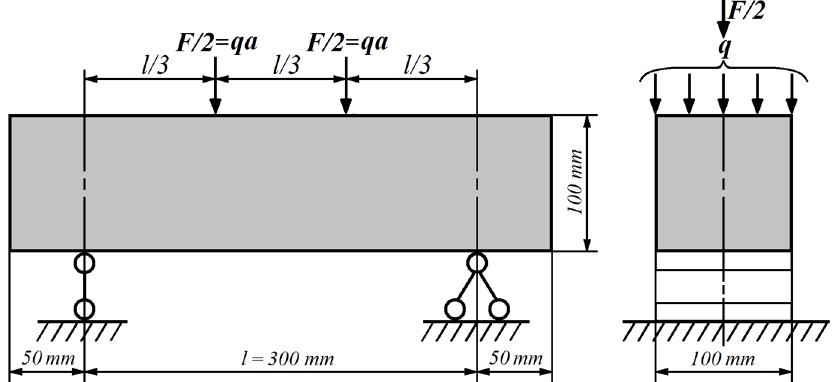
Figure 2. Load application scheme for flexural strength test according to standards ASTM C78/C78M-16, DSTU B V.2.7-214:2009 and BS EN 12390-5:2009.